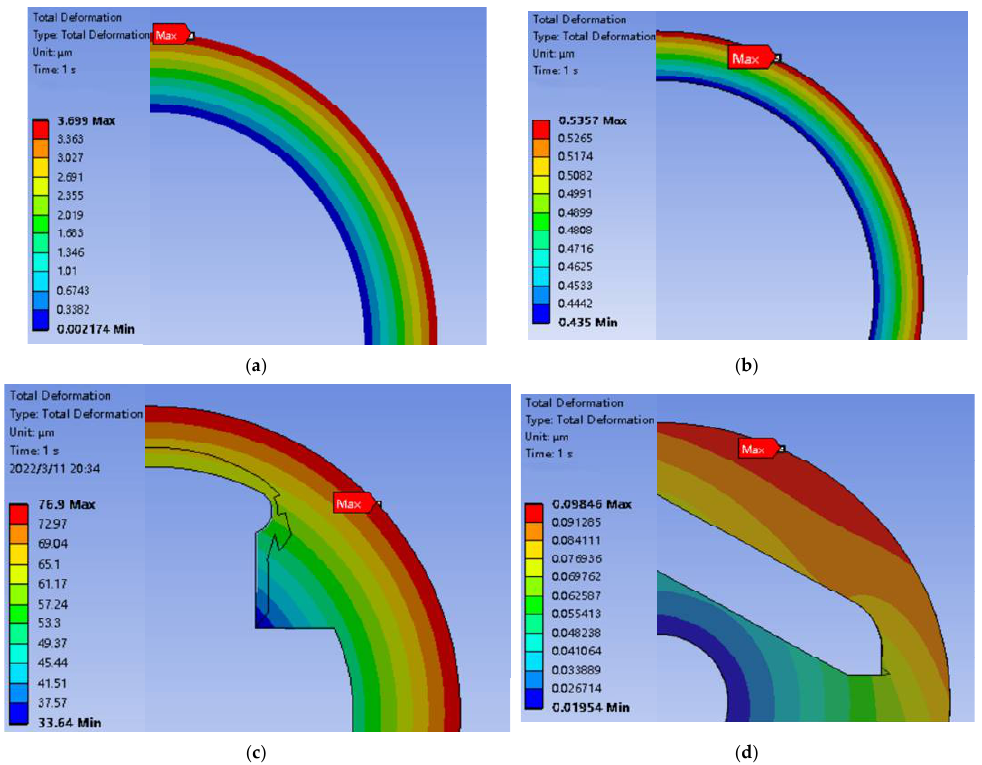
Figure 5. Total deformation distribution in the rotor at rated operation conditions (160 krpm). ( a ) M1; ( b ) M2; ( c ) M3; ( d )